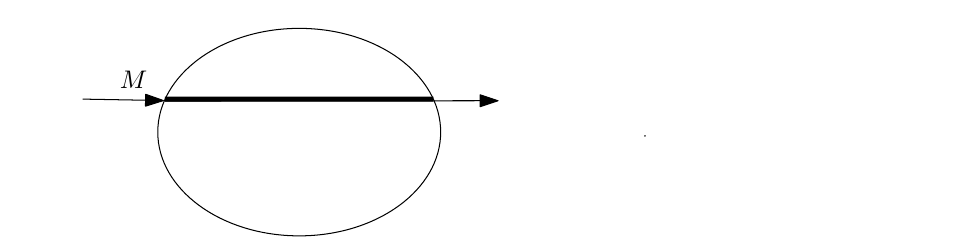
Figure 5. A drone M is traversing a straight line trajectory. Its exposure during the trajectory may be measured by the length of the path inside the risky region.